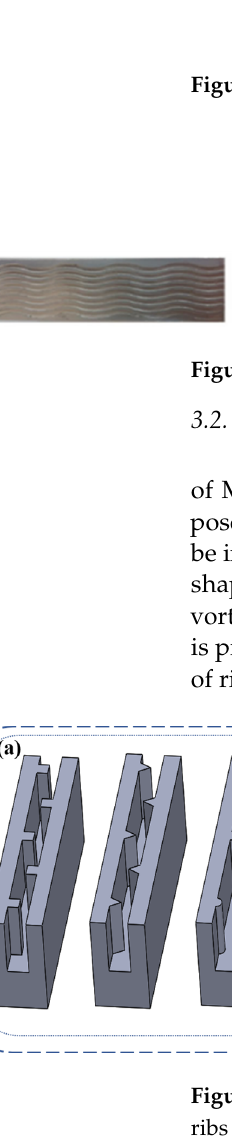
Figure 6. Highly divergent microchannel model [93].